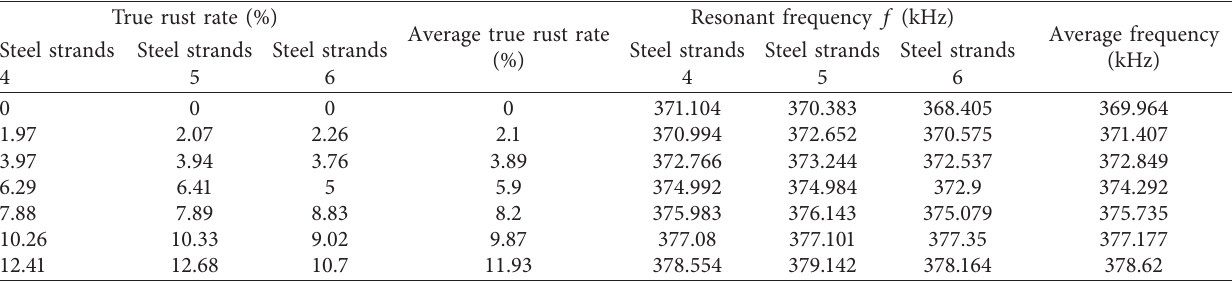
Table 4: Test data of the second group of steel strands.